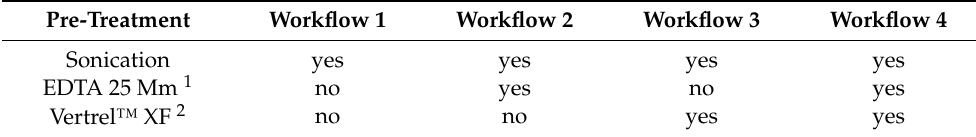
Table 1. Experimental processing workflows performed prior to VIDISCA. Pre-Treatment Workflow